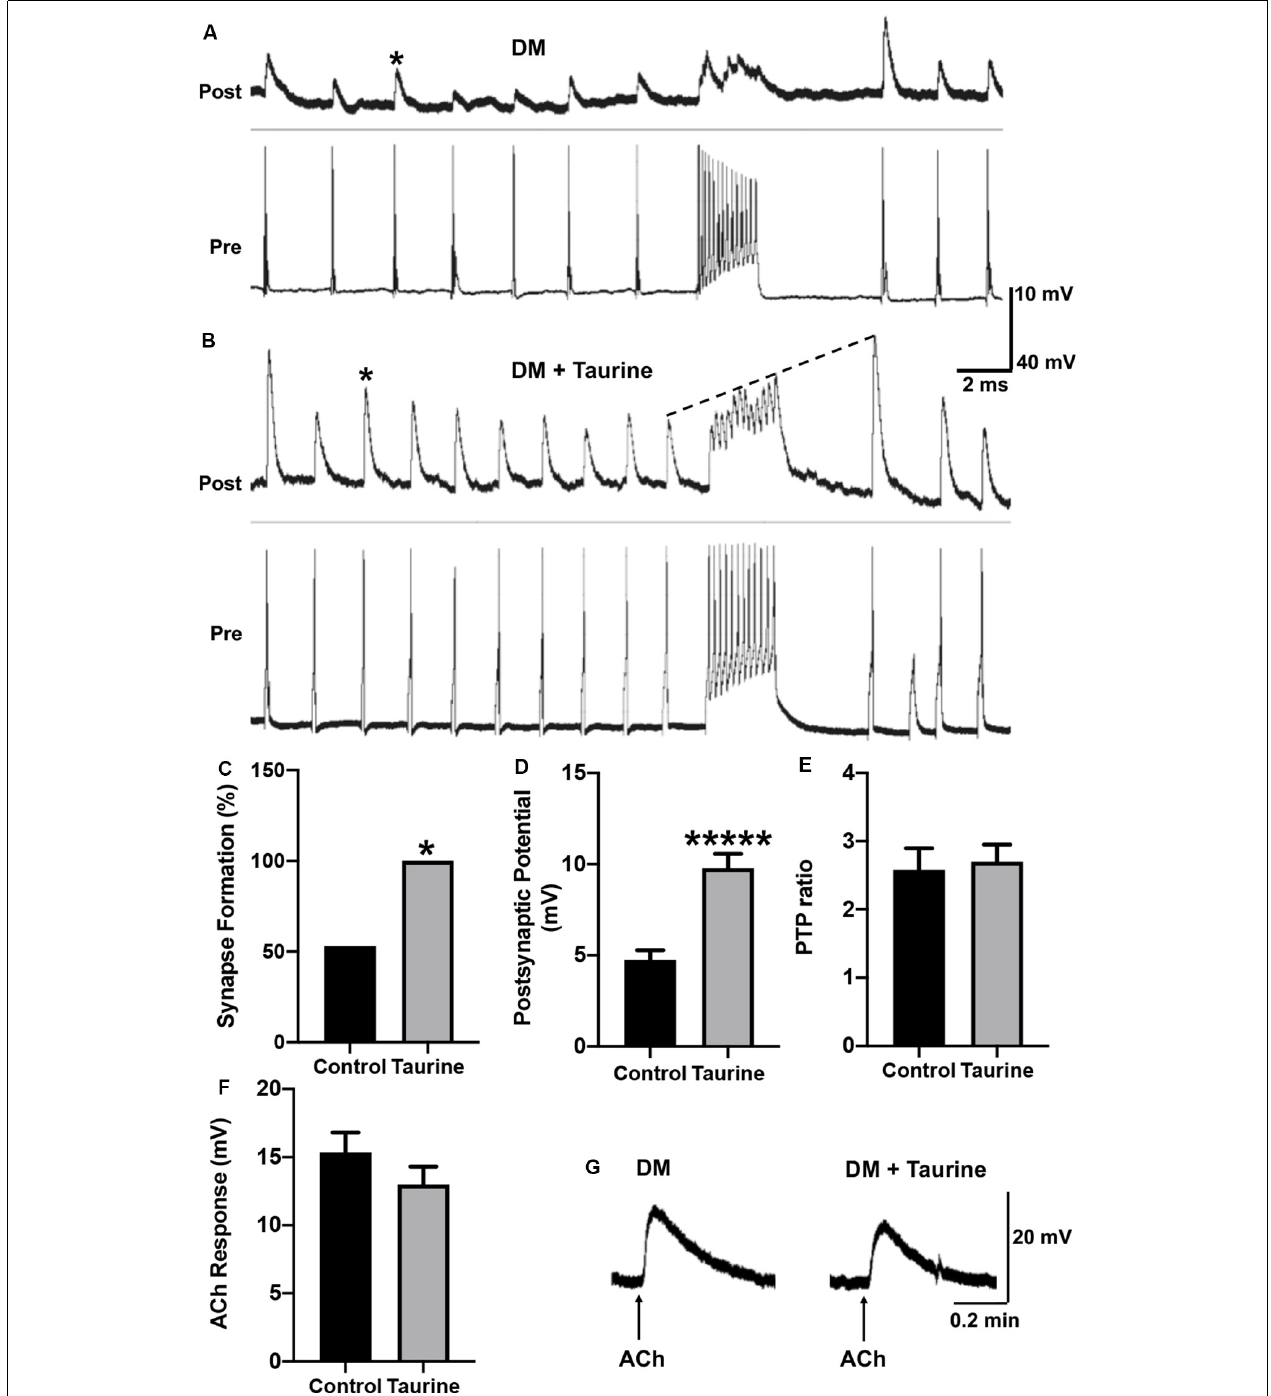
FIGURE 6 | Taurine enhances the development and strength of functional synapses between L. stagnalis central neurons but does not affect the postsynaptic response of exogenously applied transmitter. (A,B) Representative recordings show the responses of cell pairs cultured without taurine (control) and with 1 mM taurine. Asterisks denote peaks of PSPs. (C) Quantification of the incidence of synapse formation (reflected by the percent of cell pairs exhibiting 1:1 ratio of presynaptic action potential: postsynaptic cell PSPs) demonstrated that taurine enhances synaptic incidence. Specifically, 53% of control pairs formed synapses while 100% of 1 mM taurine-treated pairs formed synapses ( n = 15 for control and n = 10 for 1 mM taurine; Fisher’s exact test, p = 0.02019). (D) Statistical analyses of the efficacy of synaptic transmission (the mean amplitudes of PSPs) showed taurine significantly enhances synaptic transmission strength. The control PSP was 4.74 ± 0.54 mV and 1 mM taurine was 9.78 ± 0.79 mV ( n = 8 for control and n = 10 for 1 mM taurine; student t -test, p < 0.00001). (E) Post-tetanic potentiation